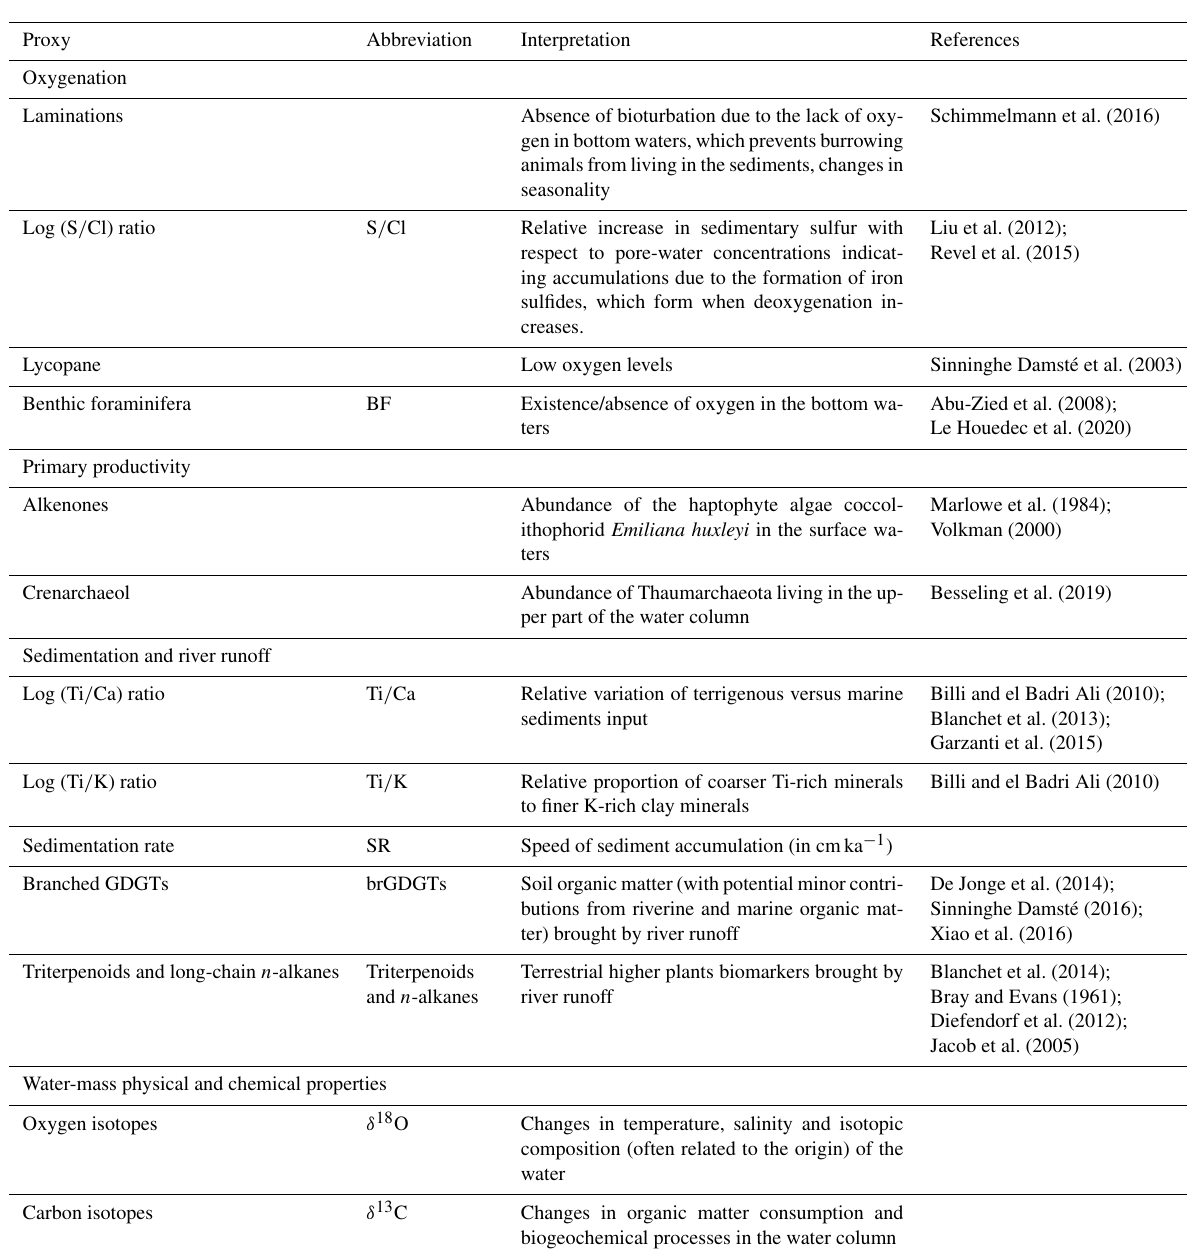
Table 3. Overview of the proxies used and their main